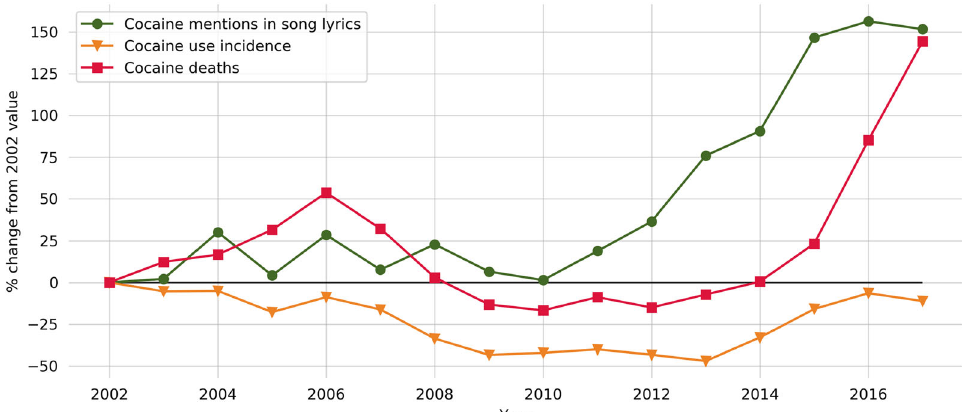
Fig. 1 Cocaine mentions in song lyrics, incidence of cocaine use, and cocaine death rate. Summarizes the percent change from the baseline year of 2002 for 2002-2016 for cocaine mentions in song lyrics, incidence of cocaine use, and cocaine death rate.